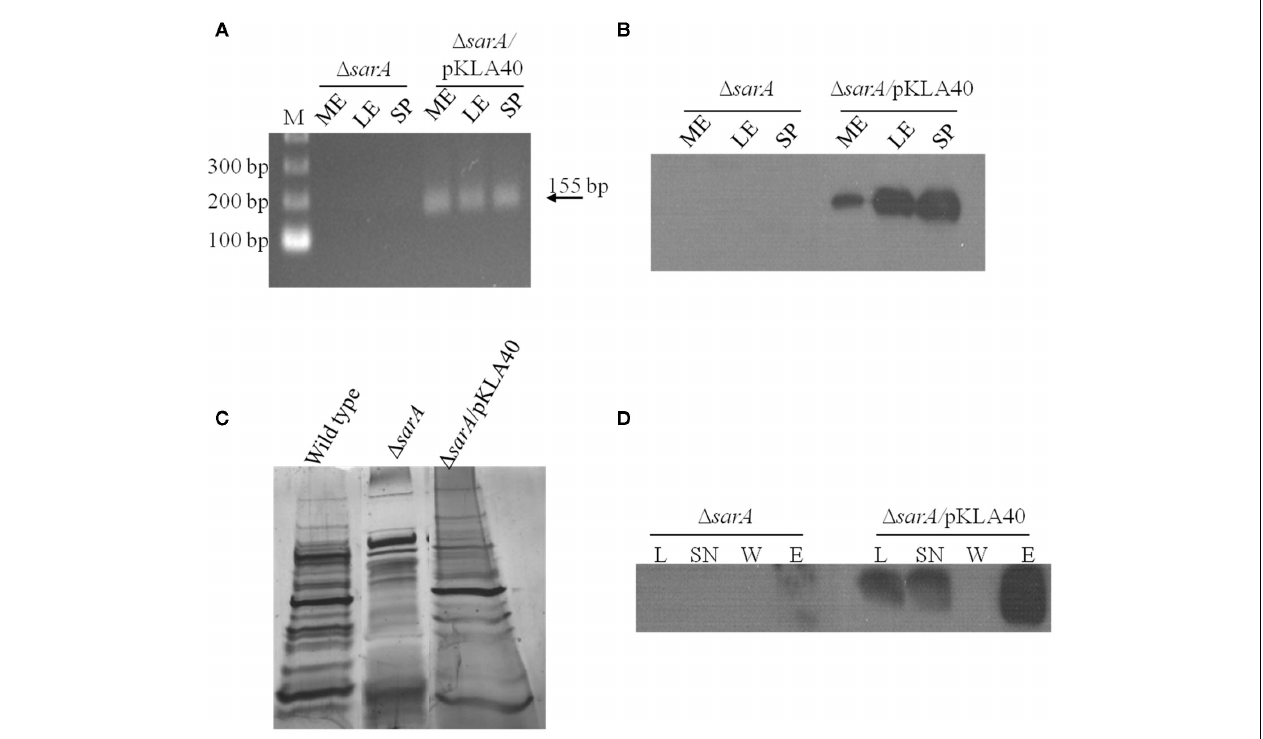
(SP) phase growth. (C) SDS-PAGE and silver staining of exoproteins purified from wild type, Δ sarA and Δ sarA harboring plasmid pKLA40 stationary phase culture supernates. (D) RNA immunoprecipitation (RIP) was performed by capturing c-Myc-SarA protein cross-linked to nucleic acids. Successful immunoprecipitation was confirmed byWestern blotting of cell lysate (L), lysate supernate (SN), wash (W), and elution (E) fractions with anti-c-Myc antibody.